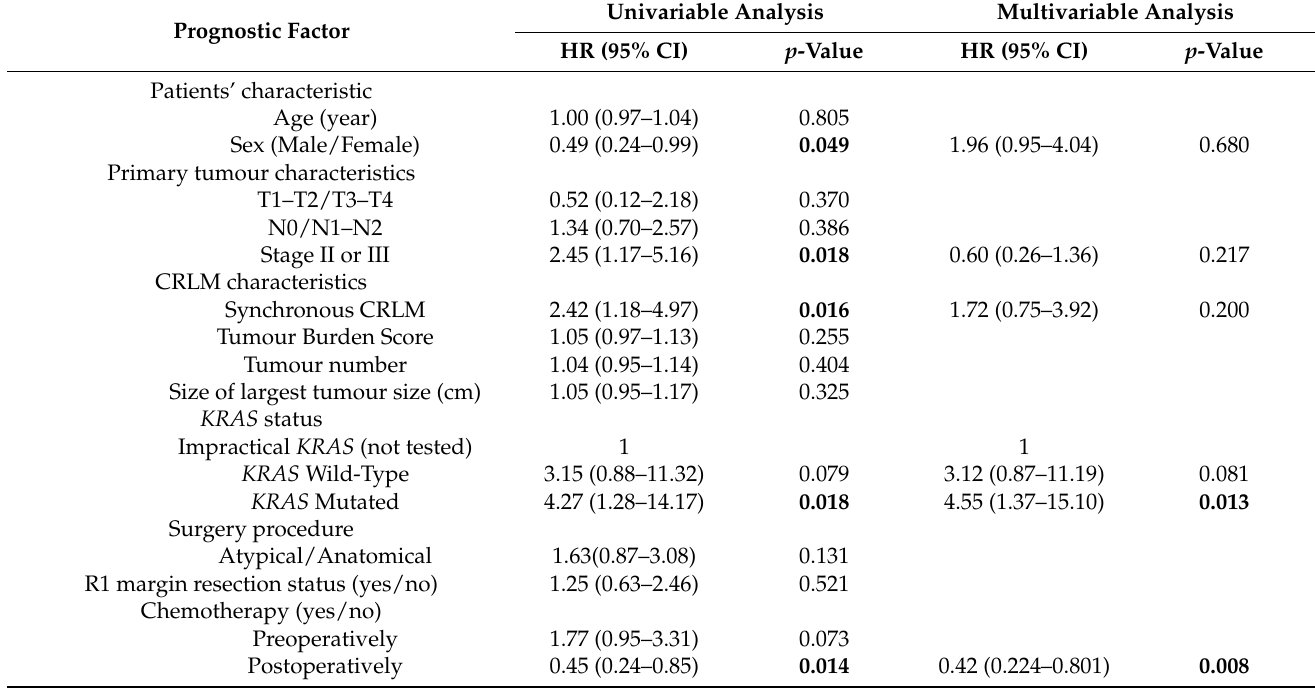
Table 4. Uni-and Multivariable Predictors of Overall Survival in the Entire